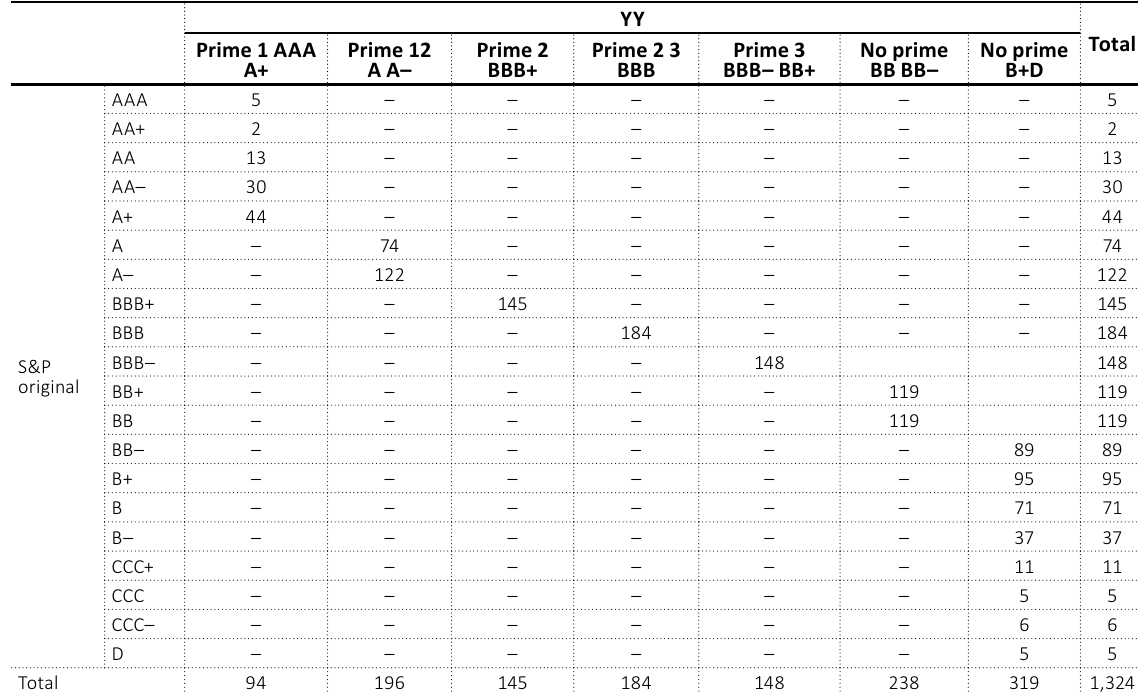
Table 4. Distribution of rates in sample I